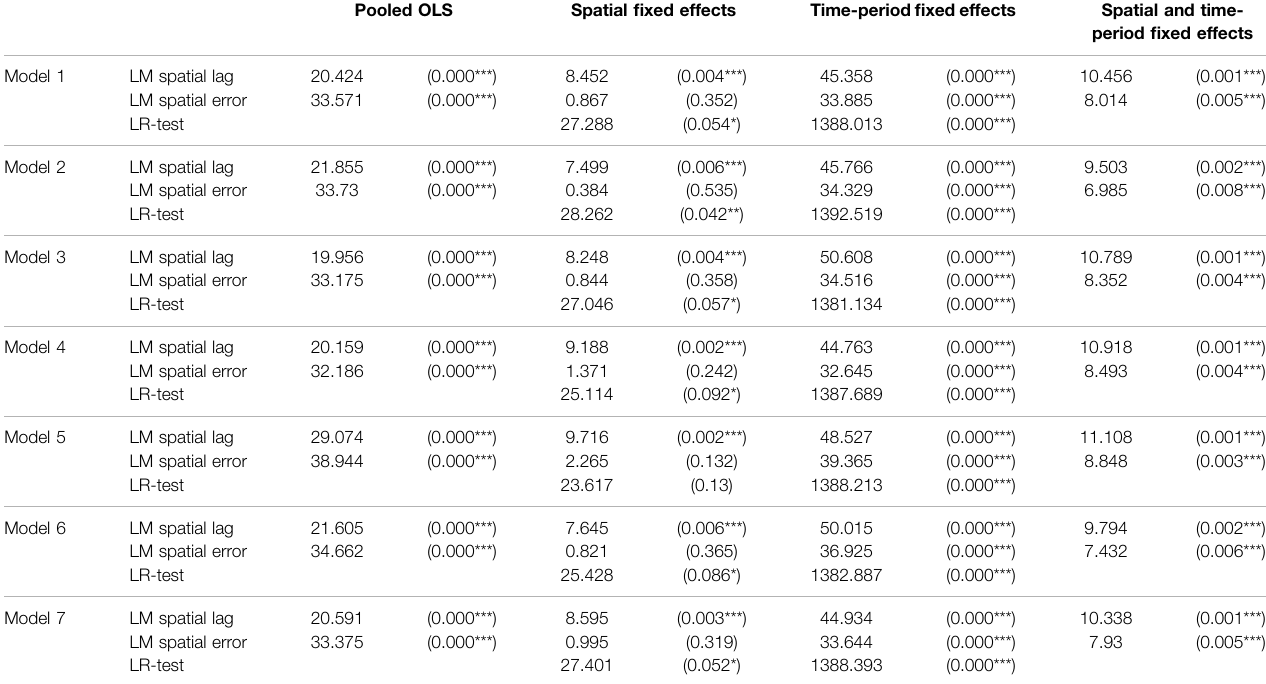
TABLE 3 | The spatial lag or the spatial error in the spatial and time-period fi xed effects model. Pooled